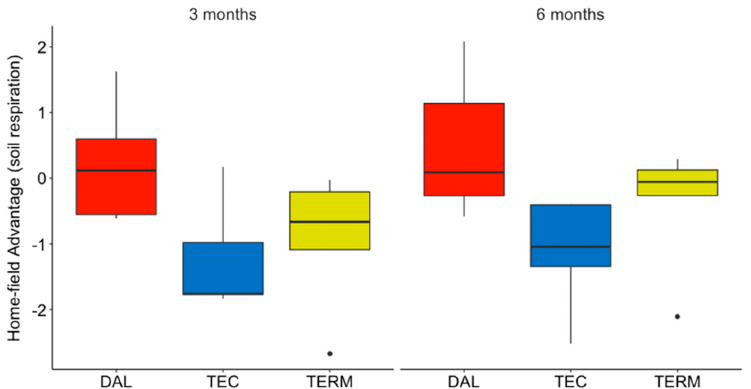
Figure 6. Homefield advantage of mean soil respiration during three and six months of a litter decomposition experiment in monoculture plantations of Tectona grandis, Dalbergia retusa and Terminalia amazonia in Panama, Central America. The homefield advantage was calculated for each litter type, where TEC is Tectona grandis , DAL is Dalbergia retusa and TERM is Terminalia amazonia litter within each plantation ( n = 5).